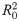
Bifurcation diagrams.Dashed curves correspond to a continuous regime transition and solid lines to a disruptive regime transition. Panel (A) shows the bifurcation diagram for parameter values of Table 1 while varying ω and M. Panel (B) shows the bifurcation diagram for parameter values of Table 1 and varying Hmax and M. Panel (C) shows the bifurcation diagram for M and R02. The black horizontal lines depict base case parameter valued. The solid vertical lines in panel (B) delimit the region M ∈ [0.365 × 103, 5.475 × 104]. The dashed vertical line shows the M value of the base case (Skiba case). In panel (D) a triple Skiba solution is depicted (resulting for the (M,R02)-parameter combination ST of panel (C)). In that case two “eradication” solutions and one “curve flattening” solutions exist. The dashed solution starts with quarantine immediately.